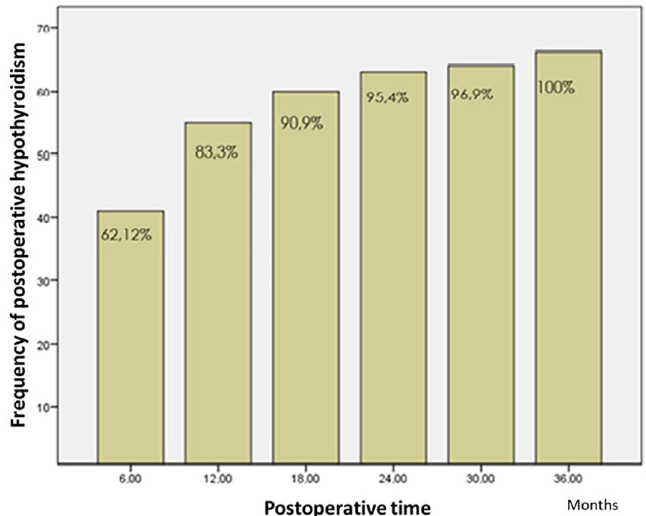
Figure 2. Time to onset of hypothyroidy.